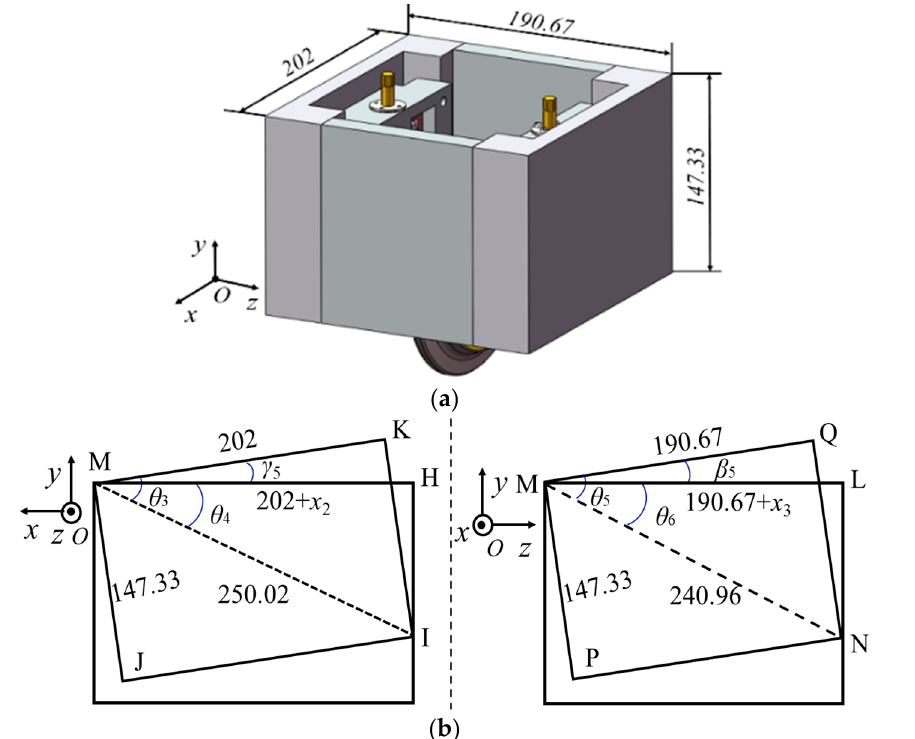
Figure 8. The welding deviation between cutter box and cutter head. ( a ) Overall dimensions of the cutter box. ( b ) The geometric model of angle deviation between the cutter box and the mounting hole of the cutter head.